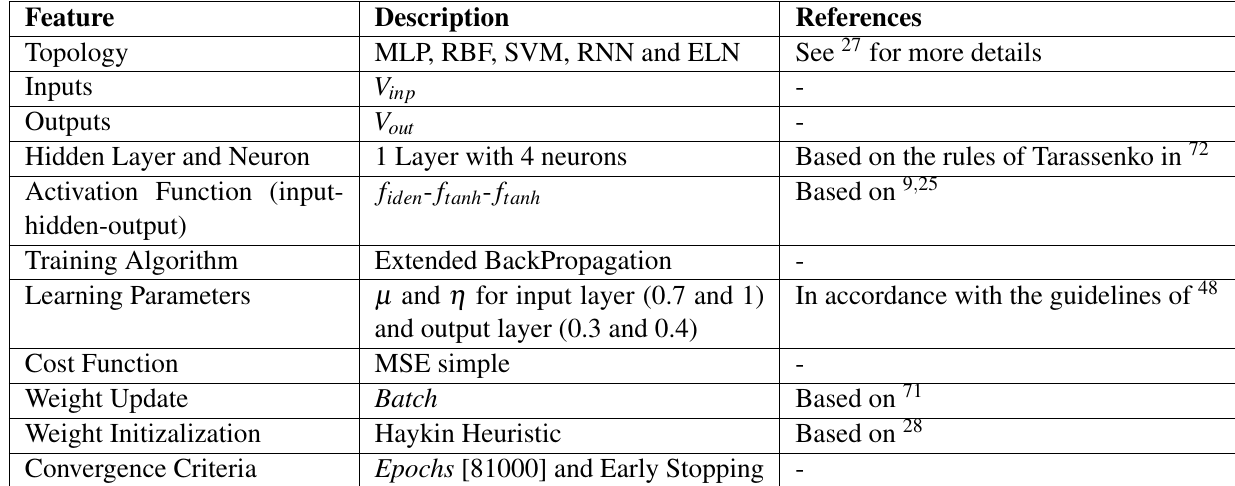
Table 2: Initial features of the ANN